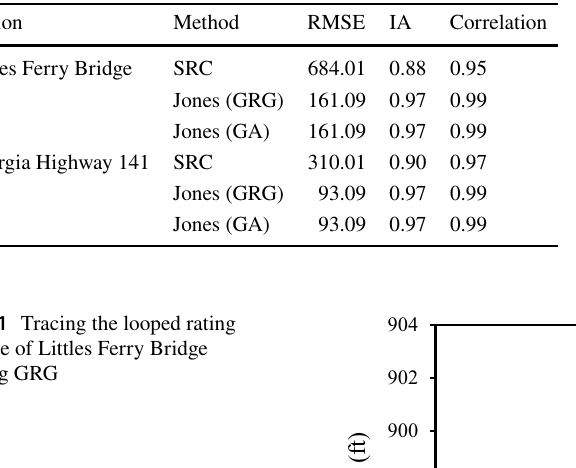
Table 4 Performance indices for two sites during validation